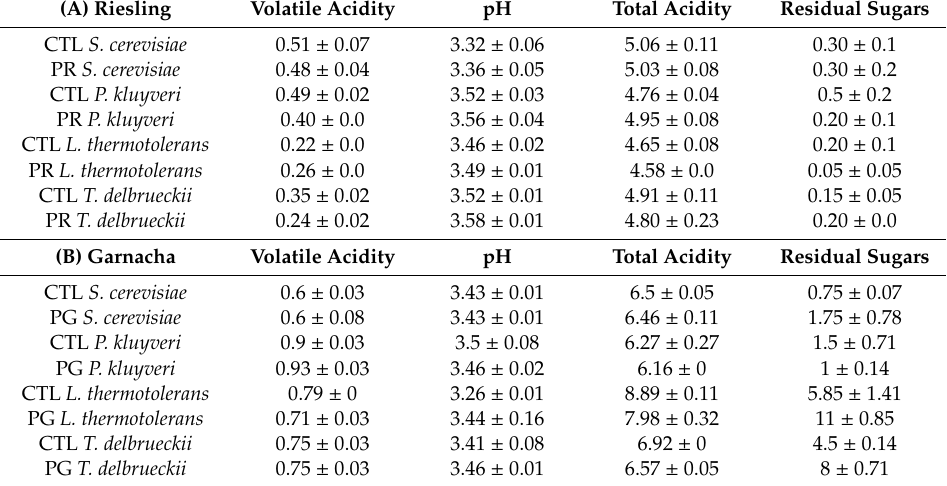
Figure 1. Experimental set-up: two independent sequential fermentation experiments with synthetic must were prepared. In the first experiment, one of the series was spiked with glycosidic precursors extracted from Riesling, and in the second experiment with precursors extracted from Garnacha grapes. Each experiment included a control with synthetic must, the series containing precursors, and a third series of synthetic wine spiked with precursors (not represented in the figure). The two first series were divided into four lots; one was inoculated with S. cerevisiae , and the others were firstly inoculated with P. kluyveri , T. delbrueckii or L. thermotolerans and, after 4 days, with the same S. cerevisiae strain. The fermented samples and unfermented controls were further aged 1, 2 and 5 weeks at 50 ◦ C in strict anoxic conditions. Table 1. The classical oenological parameters of synthetic wine: the characterization according to the classical oenological parameters of recently fermented wines from the ( A ) Riesling or ( B ) Garnacha set-up obtained by the fermentation of synthetic musts spiked with precursors (coded PR for Riesling or PG for Garnacha) or not (coded CTL). The data are the means of two biological